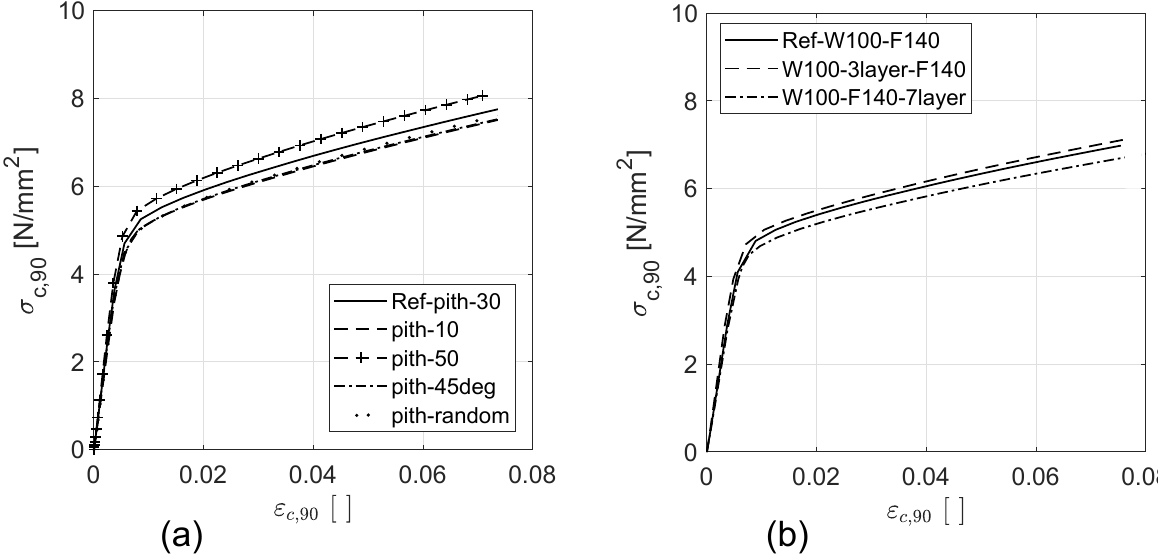
Figure 14. Compressive stress vs. strain curves for the influence of ( a ) pith locations and ( b ) number of layers in walls and